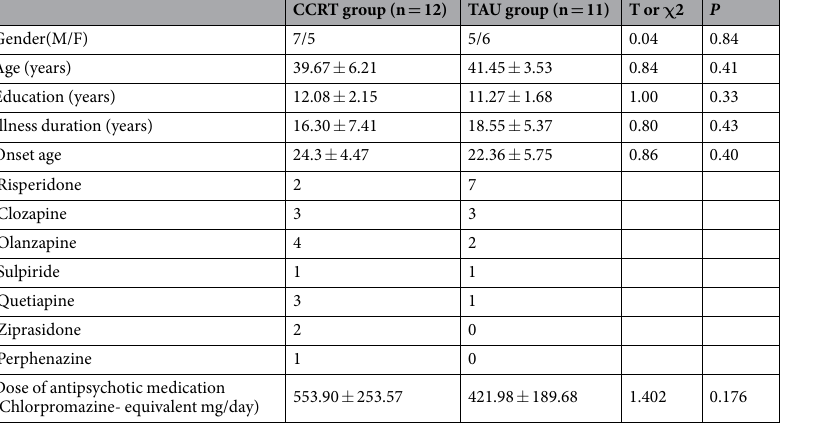
Table 1. Demographics of participants. Note: TAU = treatment-as-usual; CCRT = computerized cognitive remediation therapy PANSS = Positive and Negative Syndrome